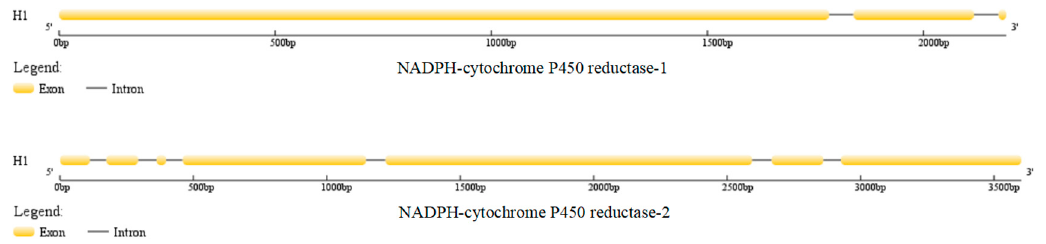
Figure 3. Structure of NADPH-cytochrome P450 reductase of O. sinensis .